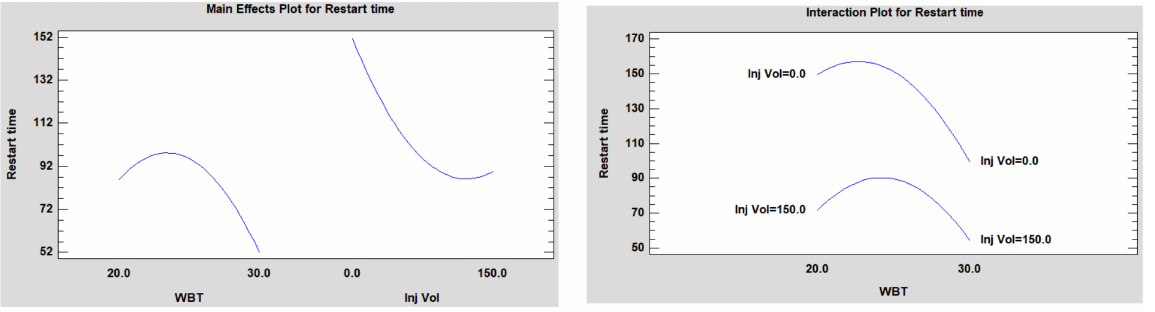
Figure 3. Main effect and interaction plots for the restart time during the gradual injection.